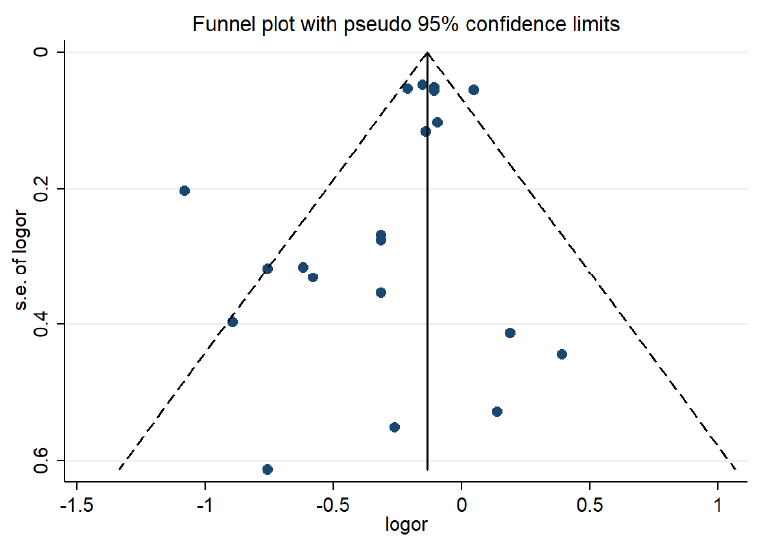
Figure 4. Funnel plot of the associations between PI and overweight/obesity. Abbreviations: s.e.: standard error; logor: the logarithm of OR.